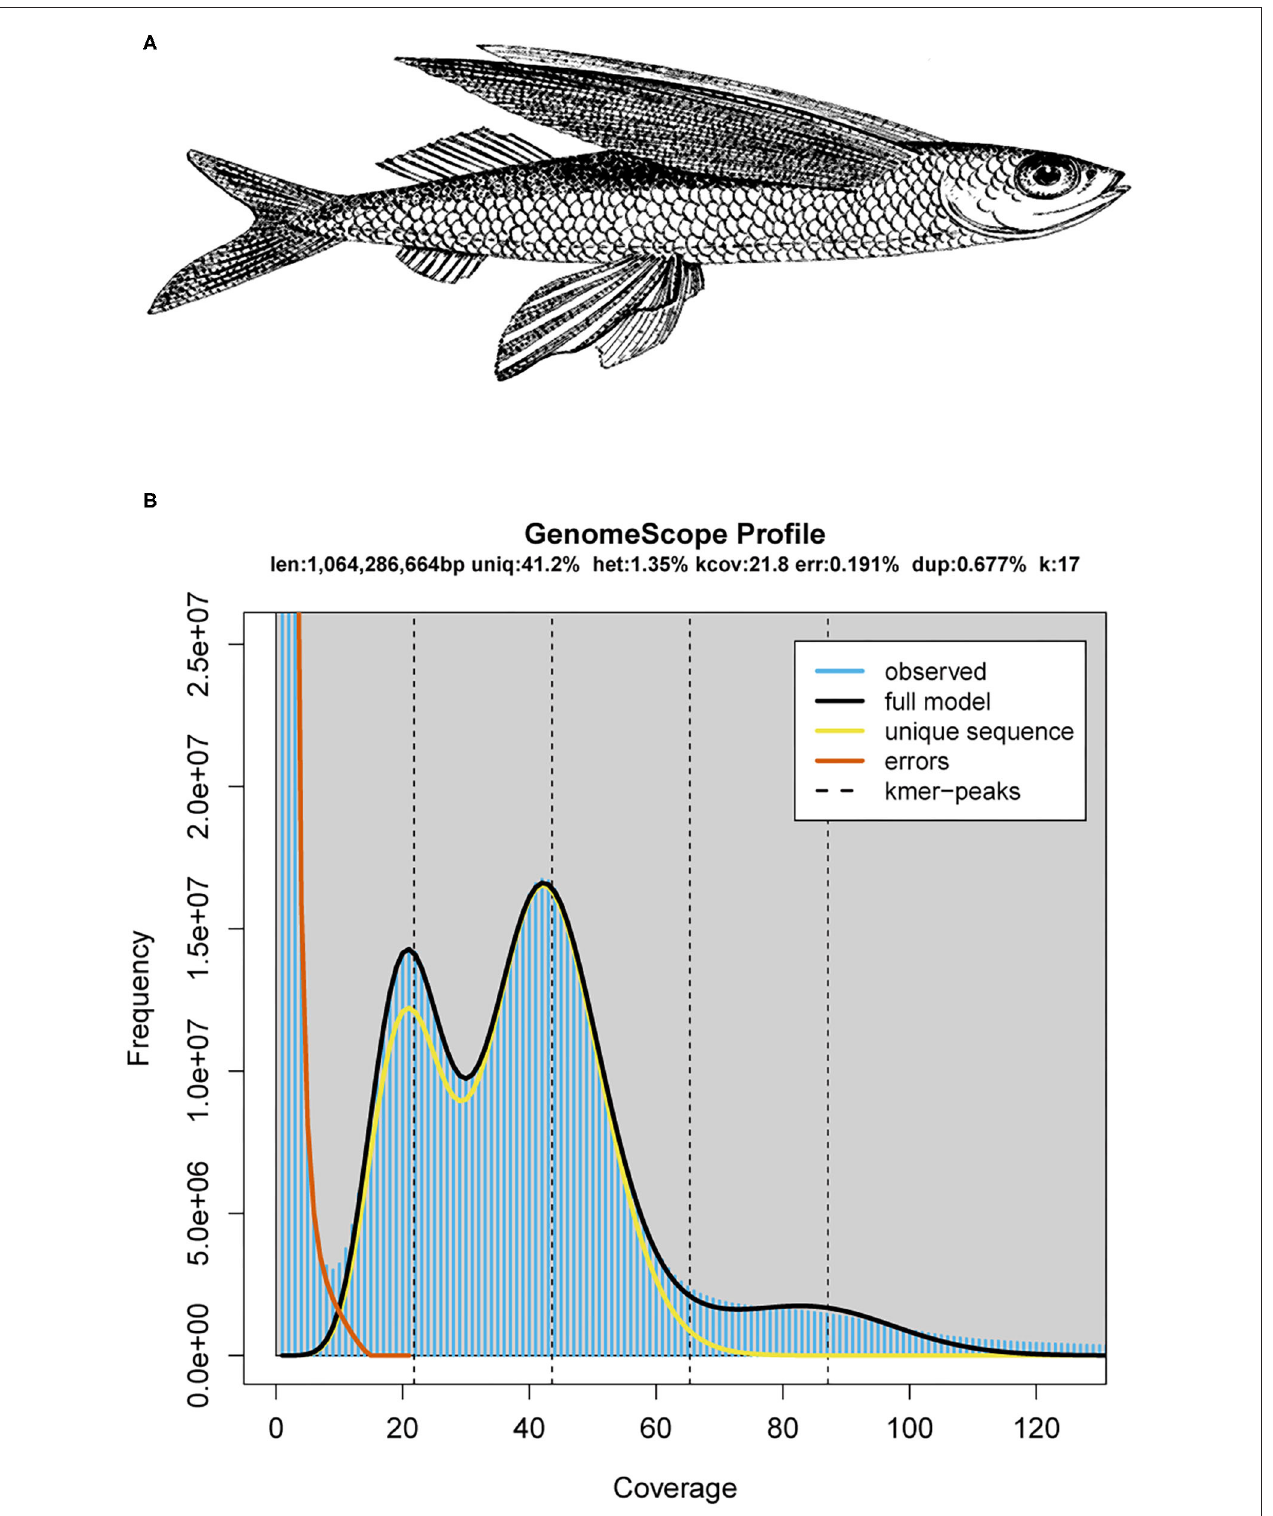
FIGURE 1 | The schematic diagram and genomics feature of the mirrorwing flyingfish. (A) A drawing of the mirrorwing flyingfish [adopted from De Bruin et al. (1995)]. (B) A k -mer analysis of the genome sequencing reads for the mirrorwing flyingfish using GenomeScope.